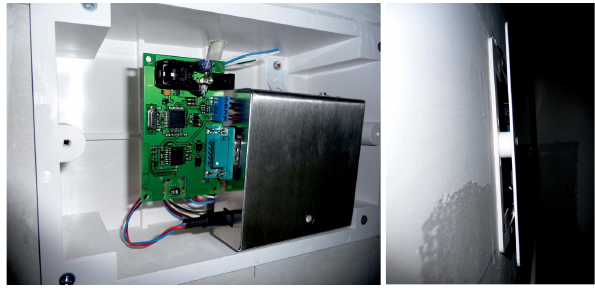
Figure 8. VOC sensors in the rooms were mounted in a box in the wall and are covered by a metal plate fixed 10mm in front of the sensor.